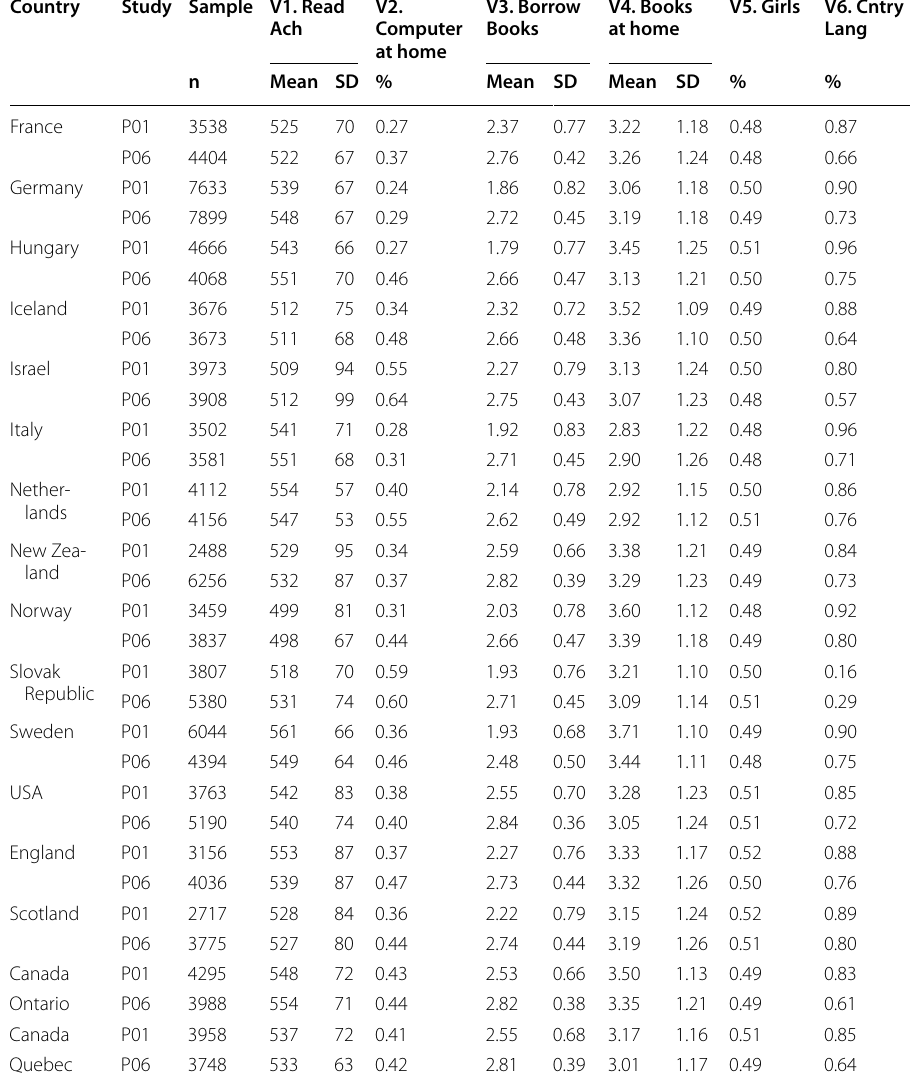
Table 2 Descriptive information at the country level, sample sizes and summary informa- tion for the selected variables for the period 2001–2006, OECD countries